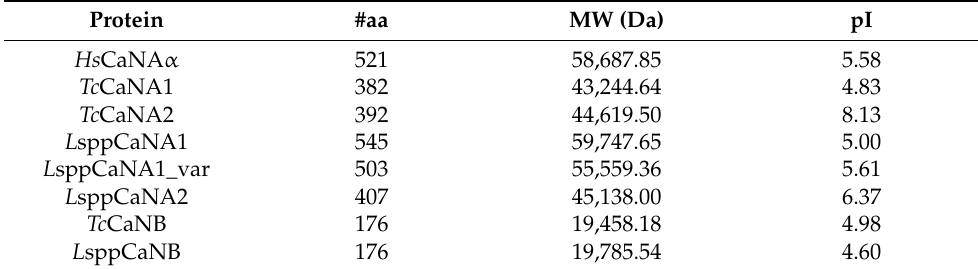
Table 1. Overview of the physical and chemical parameters of